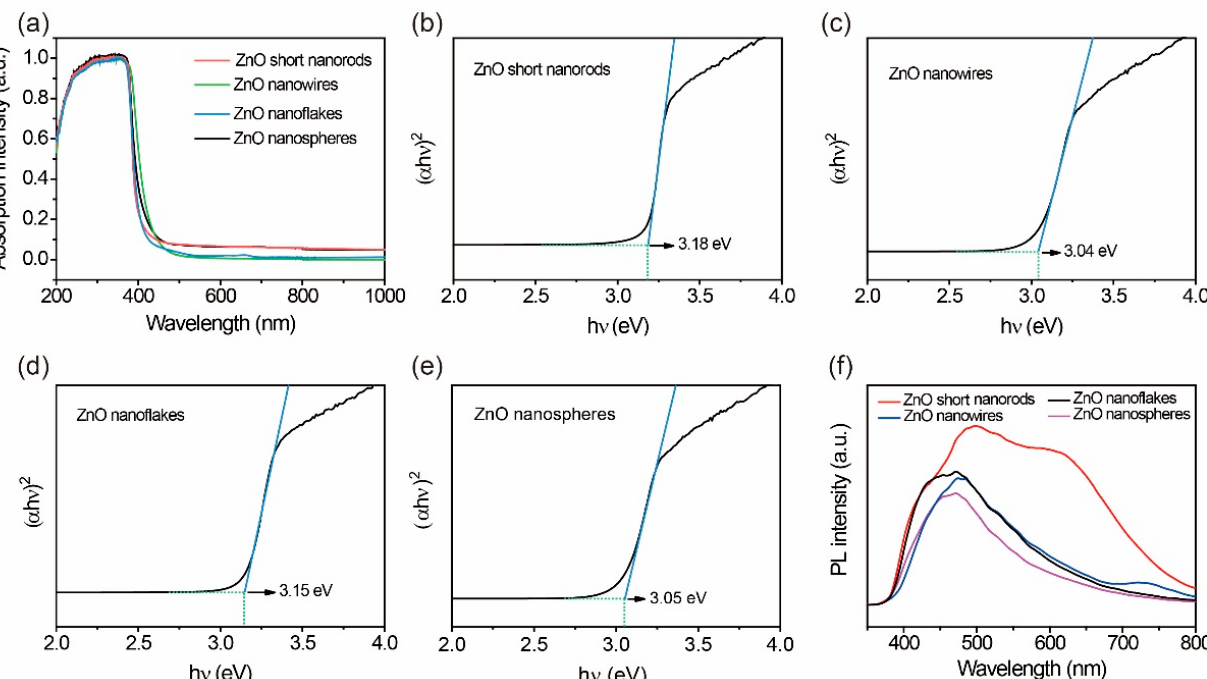
Figure 4. ( a ) UV-Vis spectra of four ZnO samples. ( b – e ) Plots of ( α h ν ) 2 versus photon energy (h ν ) for ( c ) ZnO short nanorods, ( d ) ZnO nanowires, ( e ) ZnO nanoflakes, and ( f ) ZnO nanospheres. ( f ) PL spectra of four ZnO